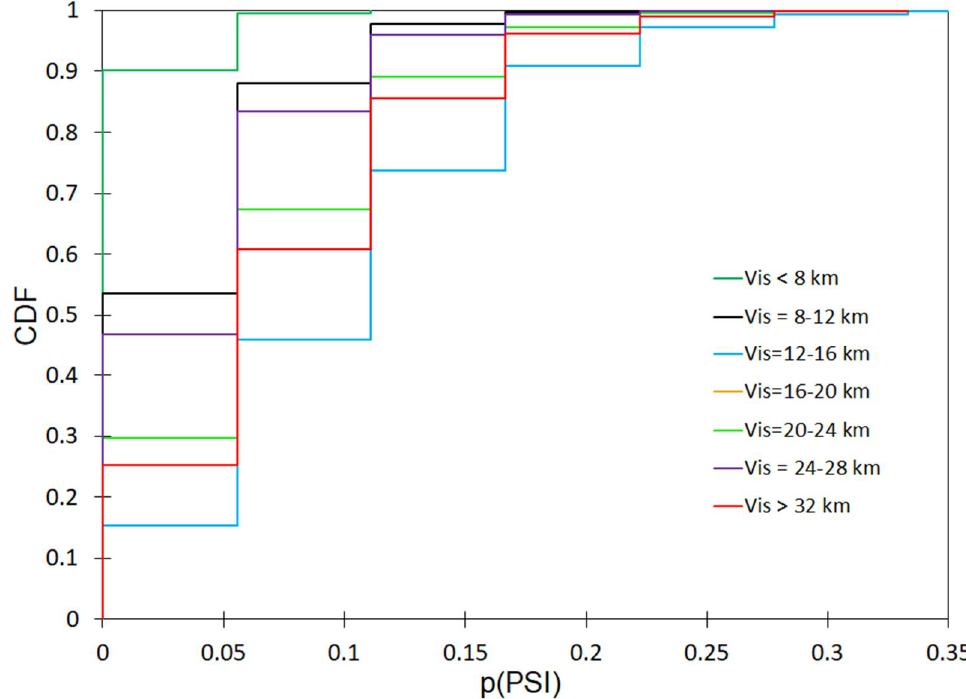
Figure A33. Effect of visibility on the incidence of mean spring mortality for dry days.